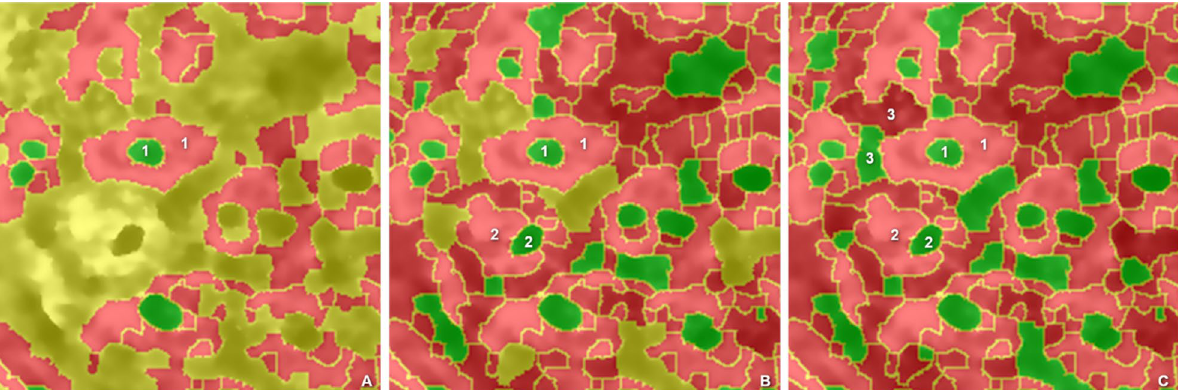
Figure 5. Classifications of nuclei. Potential nuclei (green), potential cells (red), and the residual set (yellow) for the first ( A ), second ( B ), and third ( C ) steps of the OCIN calculation. The segment-specific OCIN hierarchy index is 1 for all segments where a nucleus is fully enclosed by a cell in the first step ( A ), 2 for all segments where a nucleus is fully enclosed by a cell in the second step ( B ), and so on. An example for an OCIN hierarchy index in each step is indicated by the numbers in ( A – C